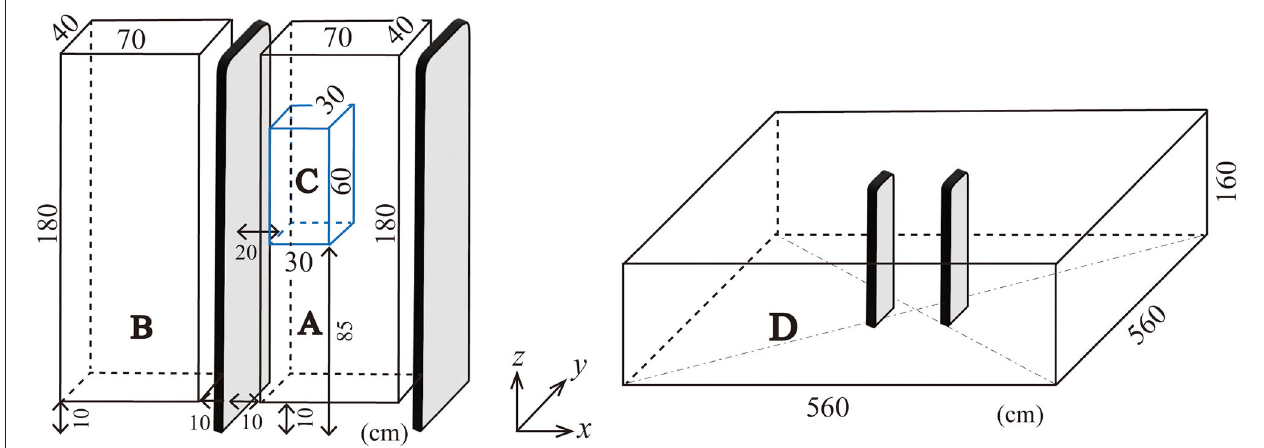
FIGURE 1 | Illustration of measurement zones.